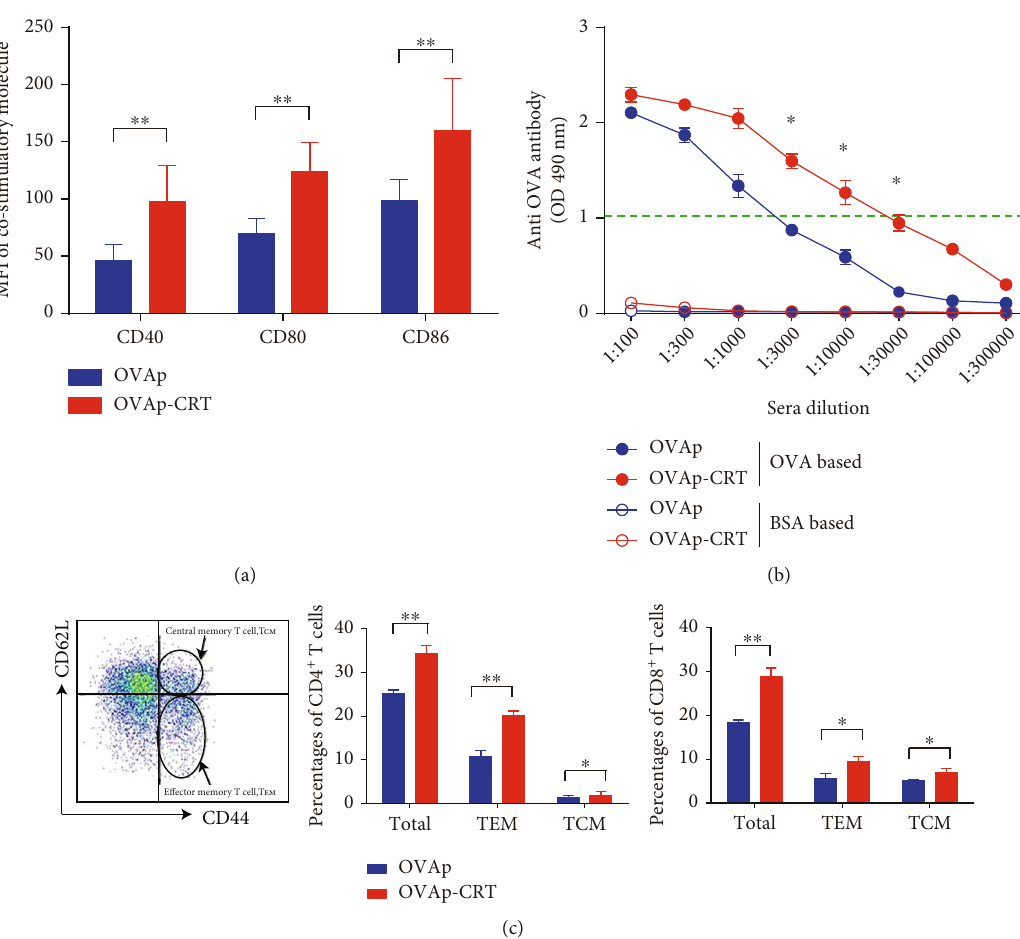
Figure 2: In vivo administration of CRT/39-272 induce splenic cDC maturation and enhance OVA-speci fi c T/B cell responses. C57BL/6 mice were treated with OVAp or OVAp-CRT for 21 days. (a) The MFI of CD40, CD80, and CD86 expression on the splenic CD11c + cDCs was analyzed by fl ow cytometry. (b) Serum OVA-speci fi c IgG concentrations were measured by ELISA. (c) ILN cells were obtained from the immunized mice on day 21, and CD4, CD8, CD44, and CD62L expressions on the ILN cells were analyzed by fl ow cytometry. The percentage of total CD4 + and CD8 + T cells and the T and T cells in CD4 + or CD8 + T cells. Data are representative of at least CM EM three independent experiments. ∗ p < 0 : 05 . ∗∗ p < 0 : 01